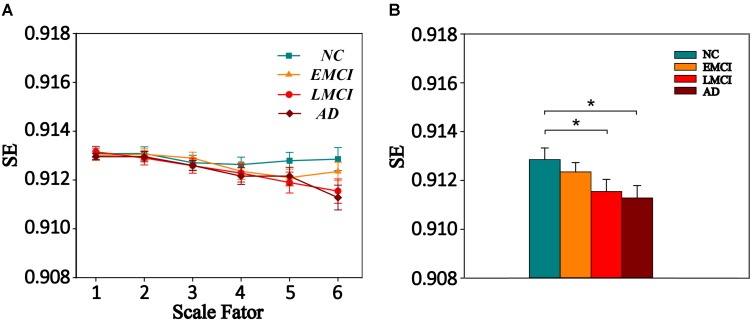
(A) MSE curve across scale factor 1–6 in gray matter (GM) for four groups. Each point represents group average SE. (B) Mean SE values of GM in the NC, EMCI, LMCI, and AD subjects on scale 6. Significant differences between each pair of the four groups (p < 0.05, two-sample t-test, uncorrected) are indicated. The error bar represents the standard error of MSE within the group. ∗ indicates p < 0.05.